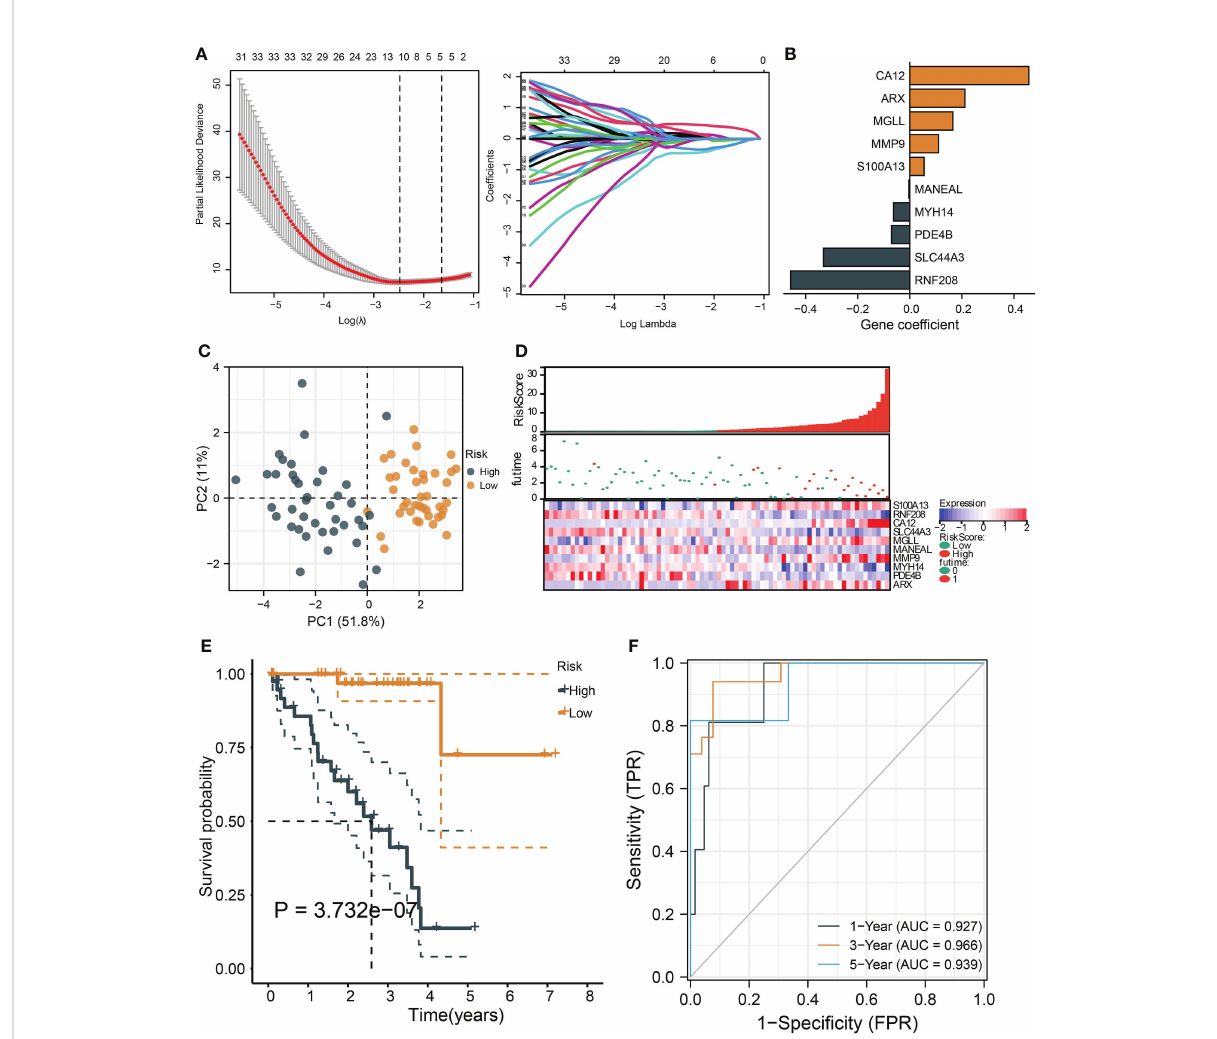
FIGURE 5 | Construction and validation of a hypoxia-based risk score. (A) The LASSO partial likelihood deviance plot and the coef fi cient pro fi les of all hypoxia gene. (B) The coef fi cients of the fi nally selected factors were presented in a bar chart. (C) The PCA plot shows the distance between the high- and low-risk group samples. (D) The risk survival table depicts the risk score gene expression pattern and patient survival status ranged by their risk score. (E) The Kaplan – Meier curve tests risk score ’ s ability to predict patient survival. (F) The ROC for estimating the model prediction accuracy of 1-, 3-, and 5-year